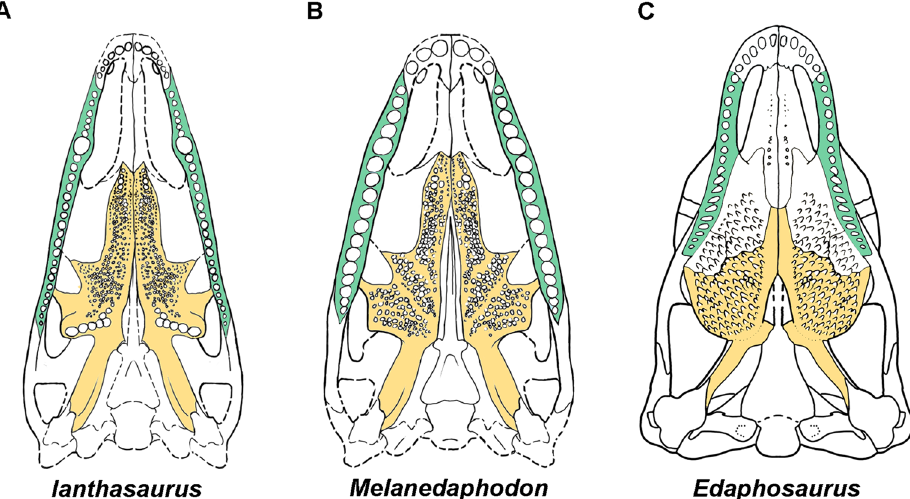
Figure 6. Comparative palatal reconstructions of three edaphosaurids. ( A ) Palate of the Late Carboniferous (Kasimovian) early edaphosaurid, Ianthasaurus hardestiorum , from Garnett, Kansas (based on observations of ROM 59933). ( B ) Palate of the Late Carboniferous (Moscovian) edaphosaurid, Melanedaphodon hovaneci gen. et sp. nov., from Linton, Ohio. ( C ) Palate of the Early Permian edaphosaurid, Edaphosaurus boanerges , from Archer County, Texas 25 . Maxilla and pterygoid are highlighted in green and yellow,